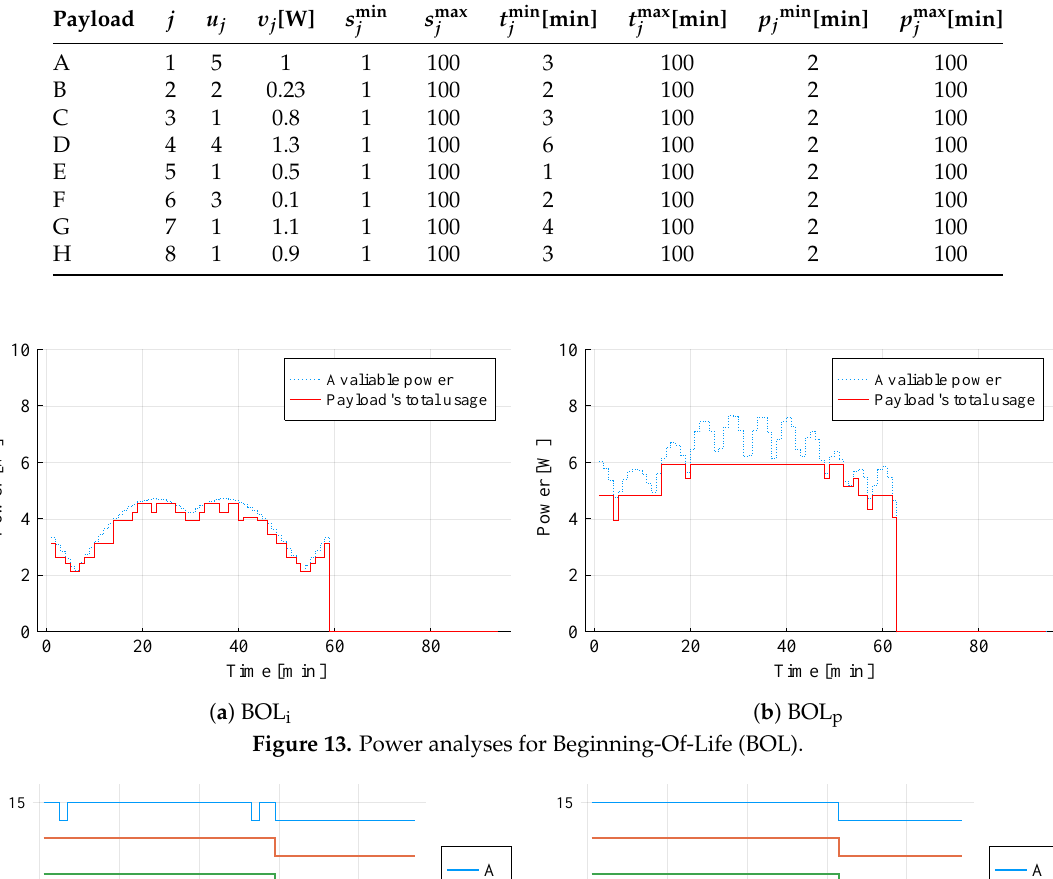
Table 5. 2U nanosatellite payloads scheduling data.